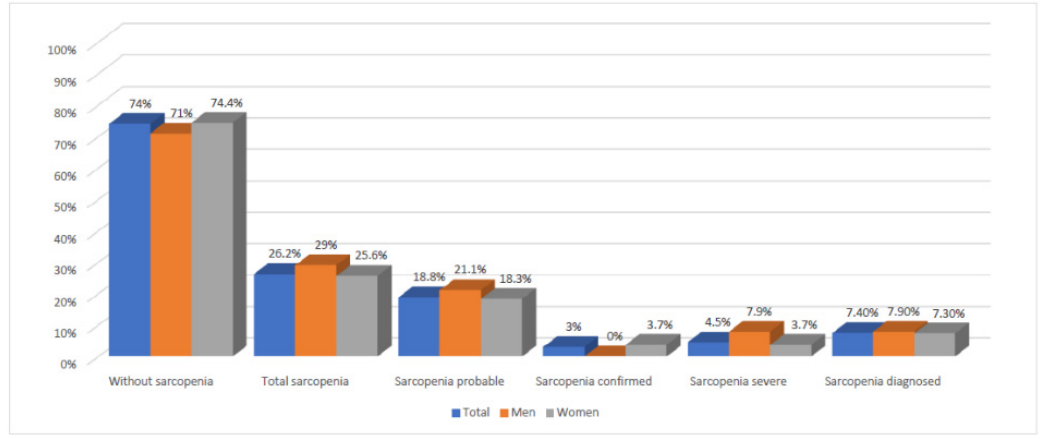
Figure 2. Categorized prevalence of sarcopenia in community-dwelling older adults according to EWGSOP 2019 diagnostic criteria and gender.